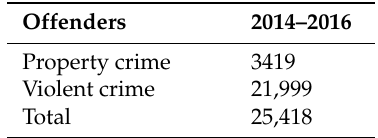
Table 1. Number of offenders charged, 2014–2016.